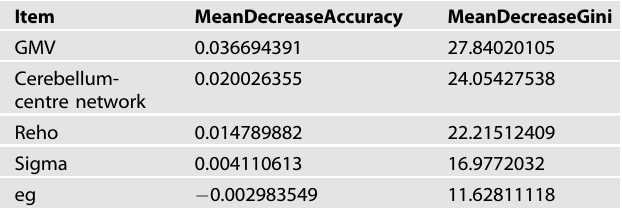
Table 2. Importance ranking of random forest